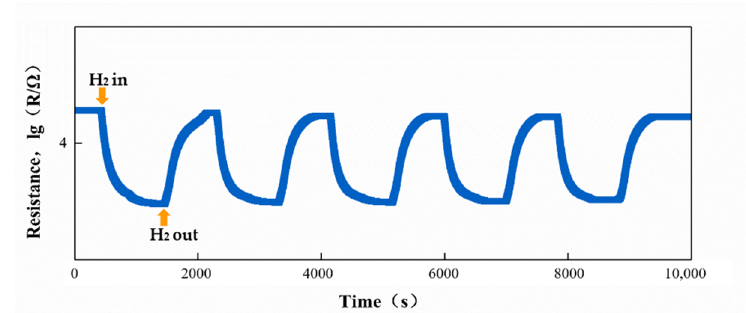
Figure 12. Cycle curve of the 12-ZnO@ZIF-8 gas sensor in hydrogen test.